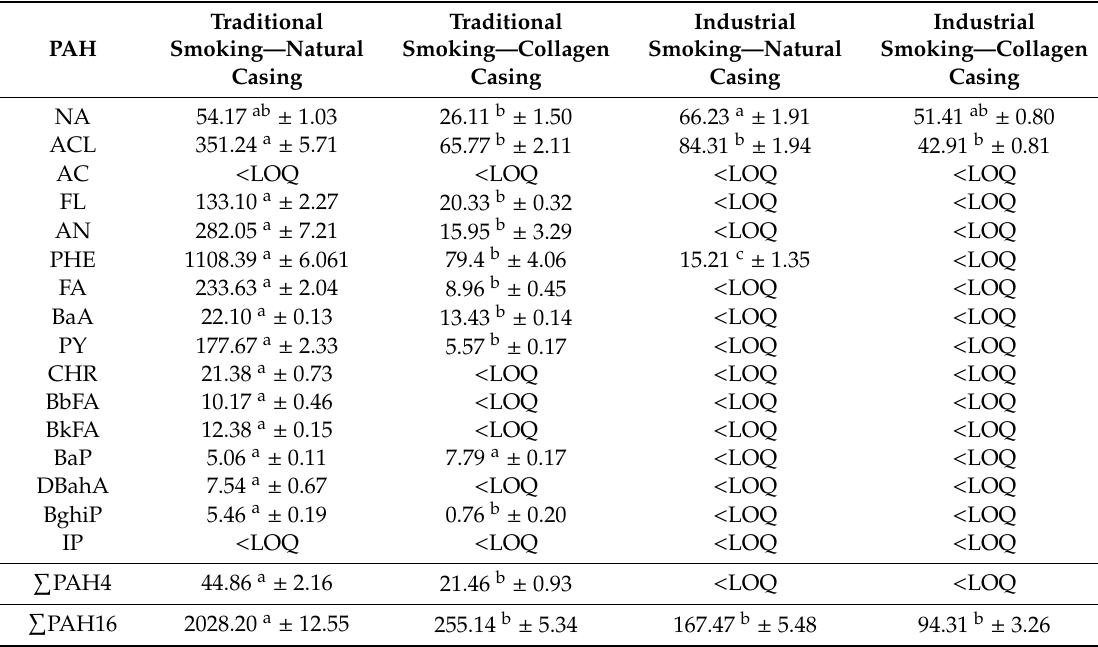
Industrial Smoking—Natural Casing